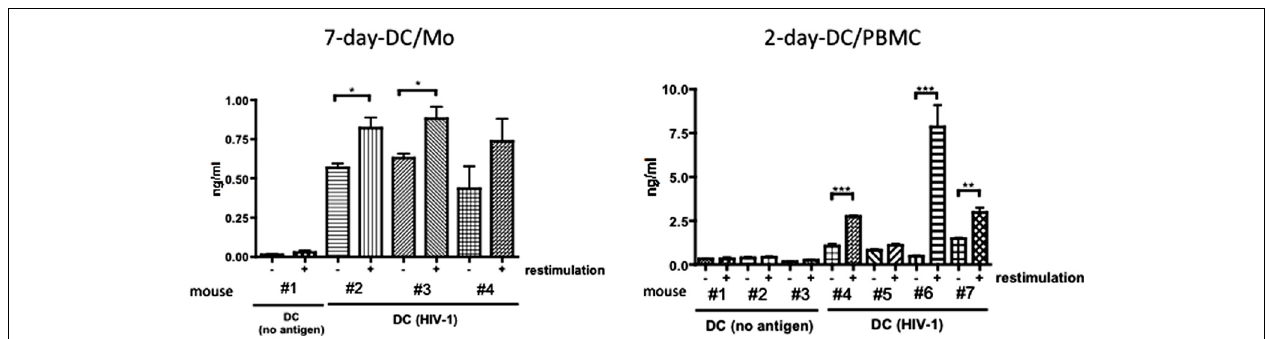
FIGURE 4 | Functional activity of the 2-days-DCs in hu-PBL-SCID mice. Fresh autologous PBMCs from normal human donors were transferred into the Rag2 − / − mouse spleen together with autologous mature MDDCs (7-day-DC/Mo) or 2-days-PBMC-derived DCs (2-day-D/PBMC) pulsed with no antigen (no antigen) or AT-2-inactivated HIV-1 (40 ng of p24). On day 7 after the first transplantation, these mice were received an intra splenic booster injection with similarly prepared DCs. Seven days after the booster injection,